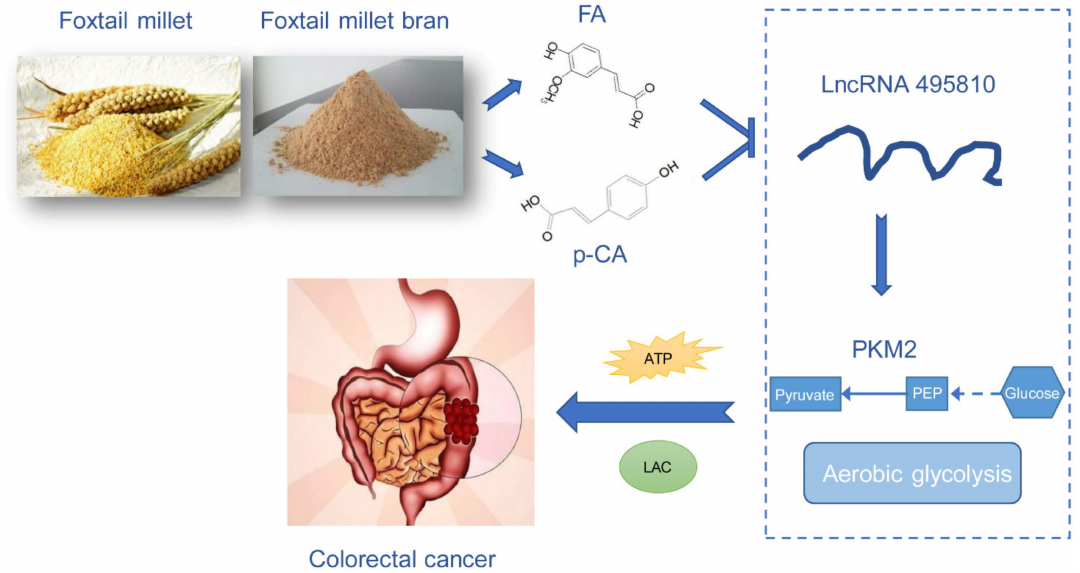
Figure 6. Schematic presentation indicates the metabolic mechanism by which FA + p-CA -induced anti-CRC effects. FA + p-CA reverse the aerobic glycolysis through the lncRNA 495810/PKM2 cascade, thereby inhibiting colon